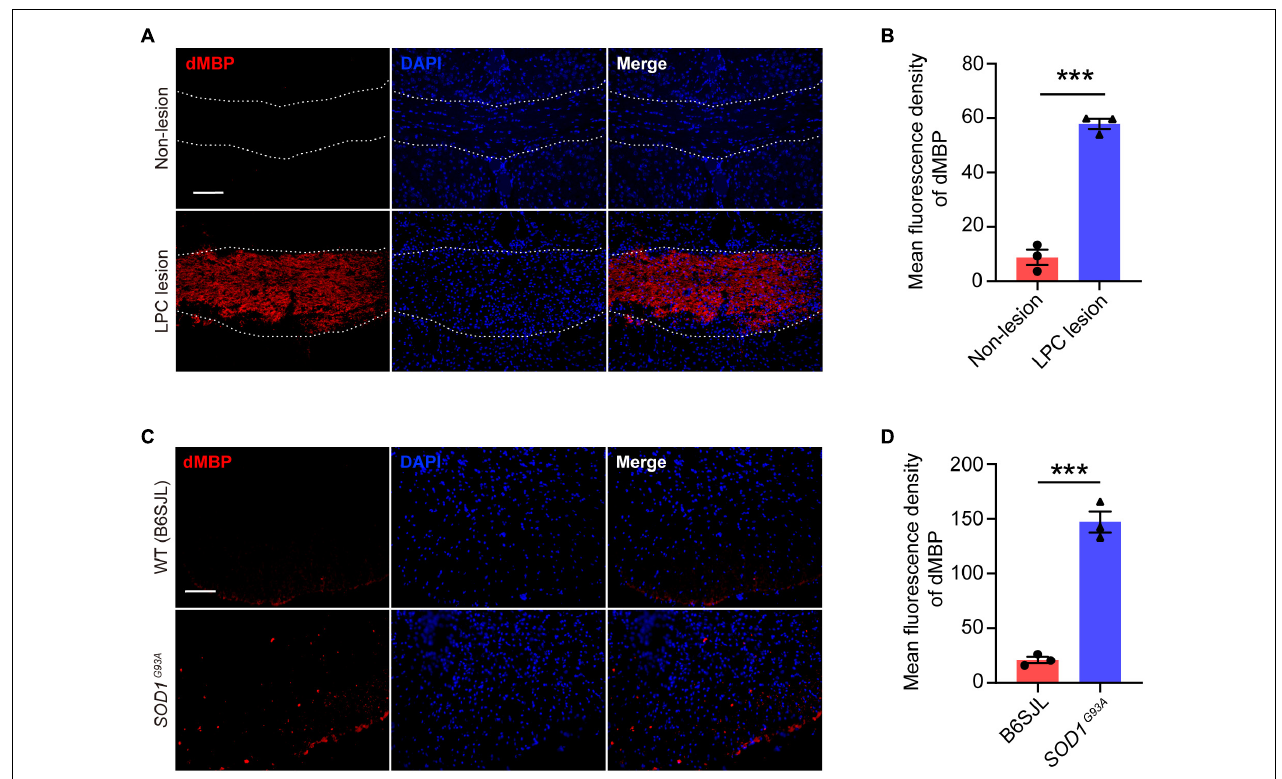
FIGURE 9 | Myelin debris accumulates in both lesioned and diseased sites in the CNS. (A,B) Representative immunofluorescence images (A) and quantification of mean fluorescence intensity (B) of degraded myelin basic protein (dMBP, red) in the corpus callosum of the mouse brain of non-lesion (upper row) and LPC-induced demyelination lesion (lower row) ( n = 3). (C,D) Representative immunofluorescence images (C) and quantification of mean fluorescence intensity (D) of dMBP (red) in the spinal cord of SOD1 G 93 A mice (lower row) and their littermates B6SJL mice (upper row) ( n = 3). Scale bars = 100 µ m (A,C) . Data are presented as mean ± SEM. Statistical tests: unpaired two-tailed t -test (B,D) ; *** p <